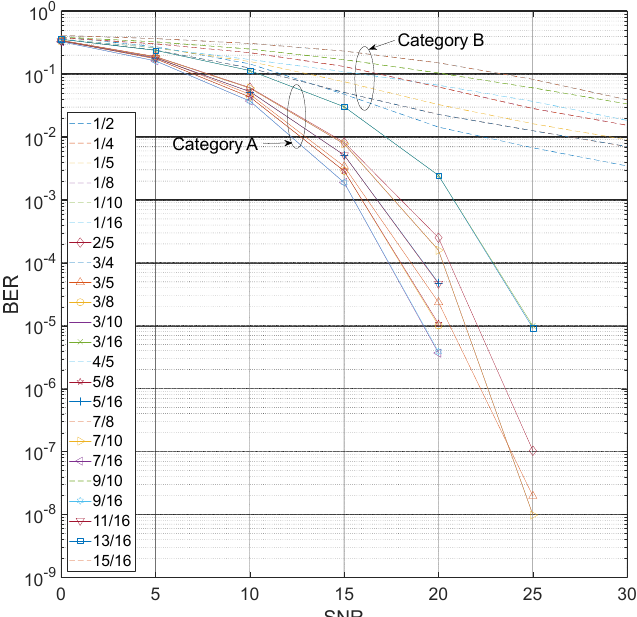
Figure 7. Error performance of CPM-OFDM for 23 rational values of modulation index h with N = 512 and transmitter-receiver distance 500 meters.